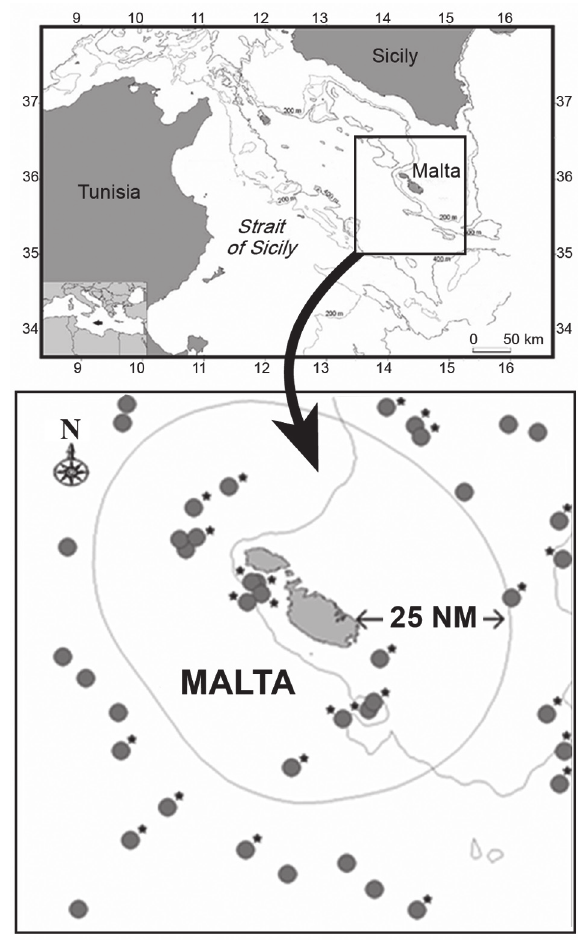
Fig 1. – Map of the study area showing the location the General Fisheries Commission for the Mediterranean geographical sub-area 15 (the quadrilateral south of Sicily). The oval around Malta repre- sents the boundary of the Maltese 25 NM Fisheries Management Zone (FMZ). The filled circles mark the position of the trawl sam- pling stations; stations from where box-cores were collected are in- dicated by an asterisk. The 200 m depth contour is also